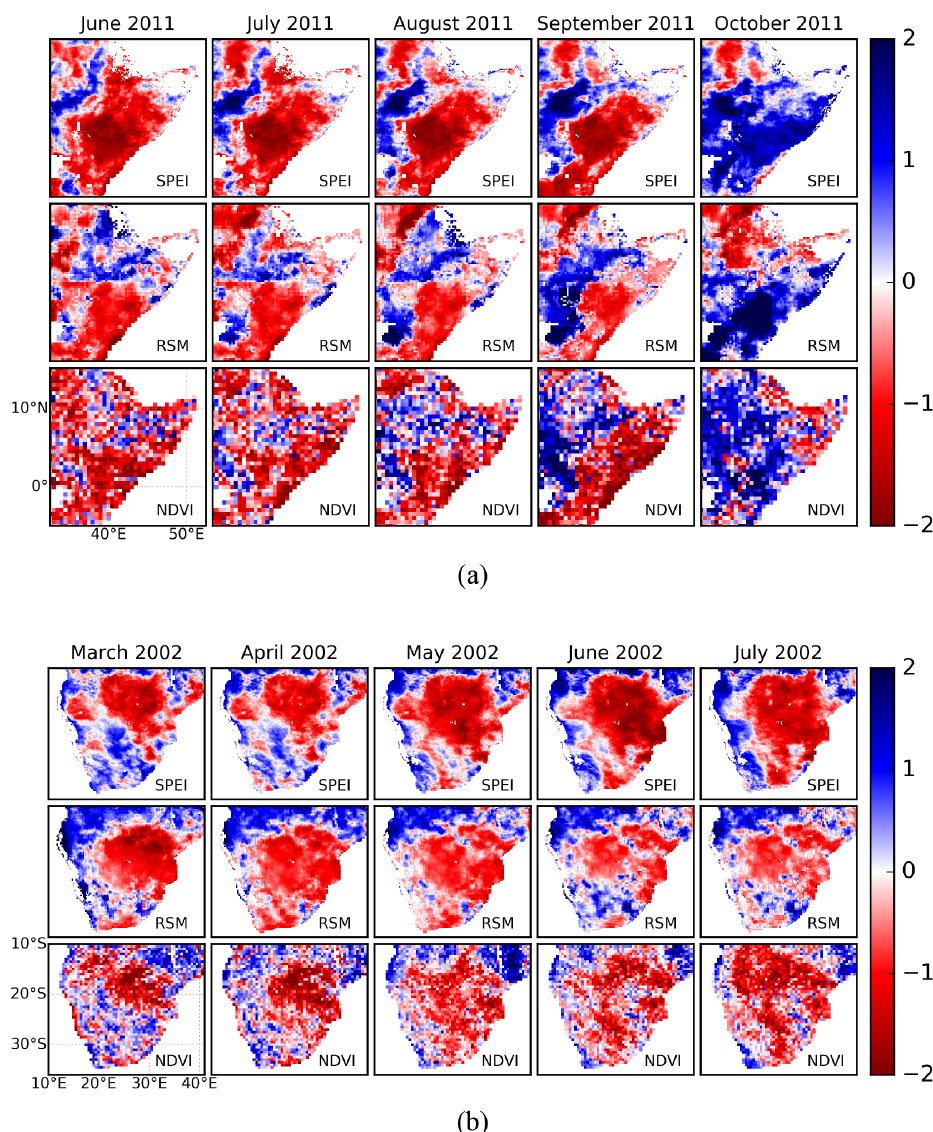
Figure 6. Evolution of the spatial patterns of 6-month SPEI-HR, NDVI and root zone soil moisture (RSM) during the 2011 East Africa drought (a) and 2002 southern Africa drought (b)